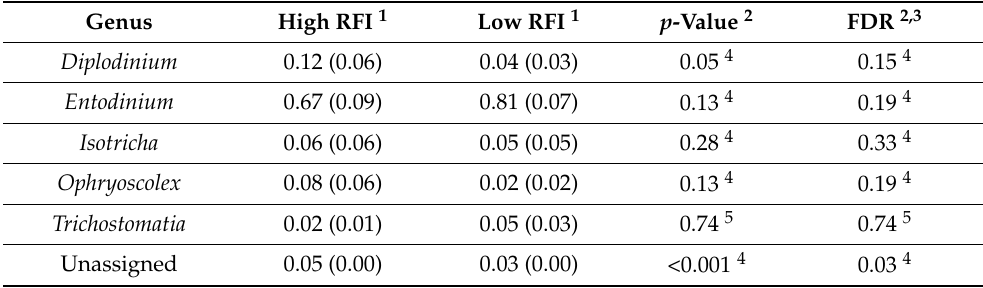
Table 3. Genus-level taxon differences between high- and low-residual feed intake (RFI) steers. Genus